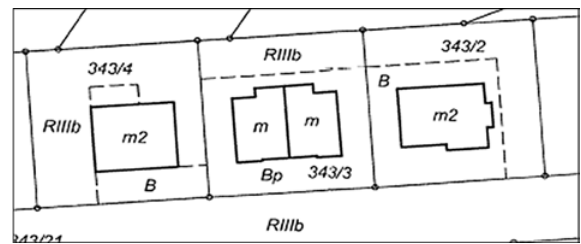
Fig. 1. Agricultural land on built-up housing lots – an